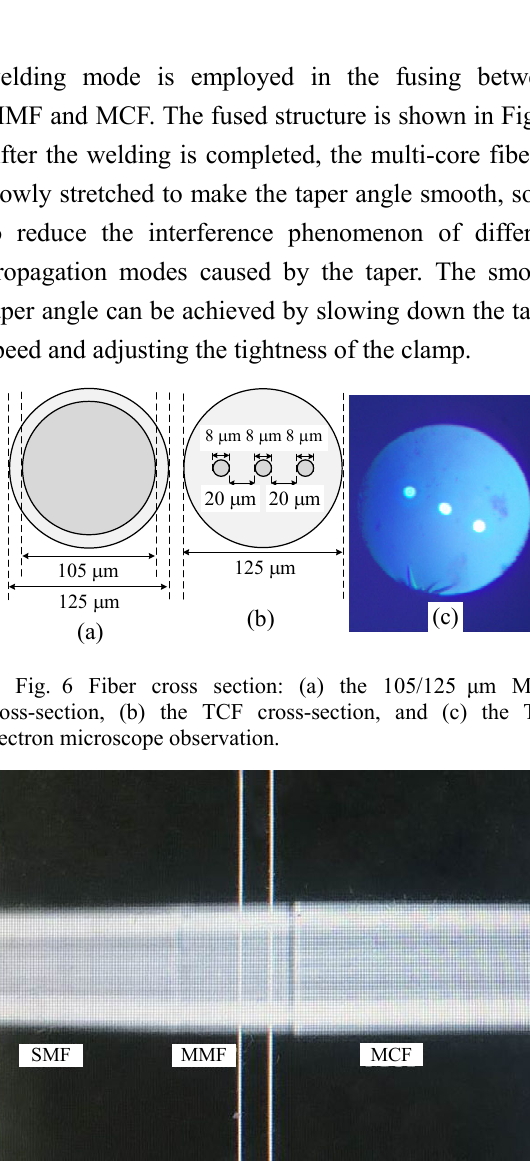
Fig. 7 Fused structure.